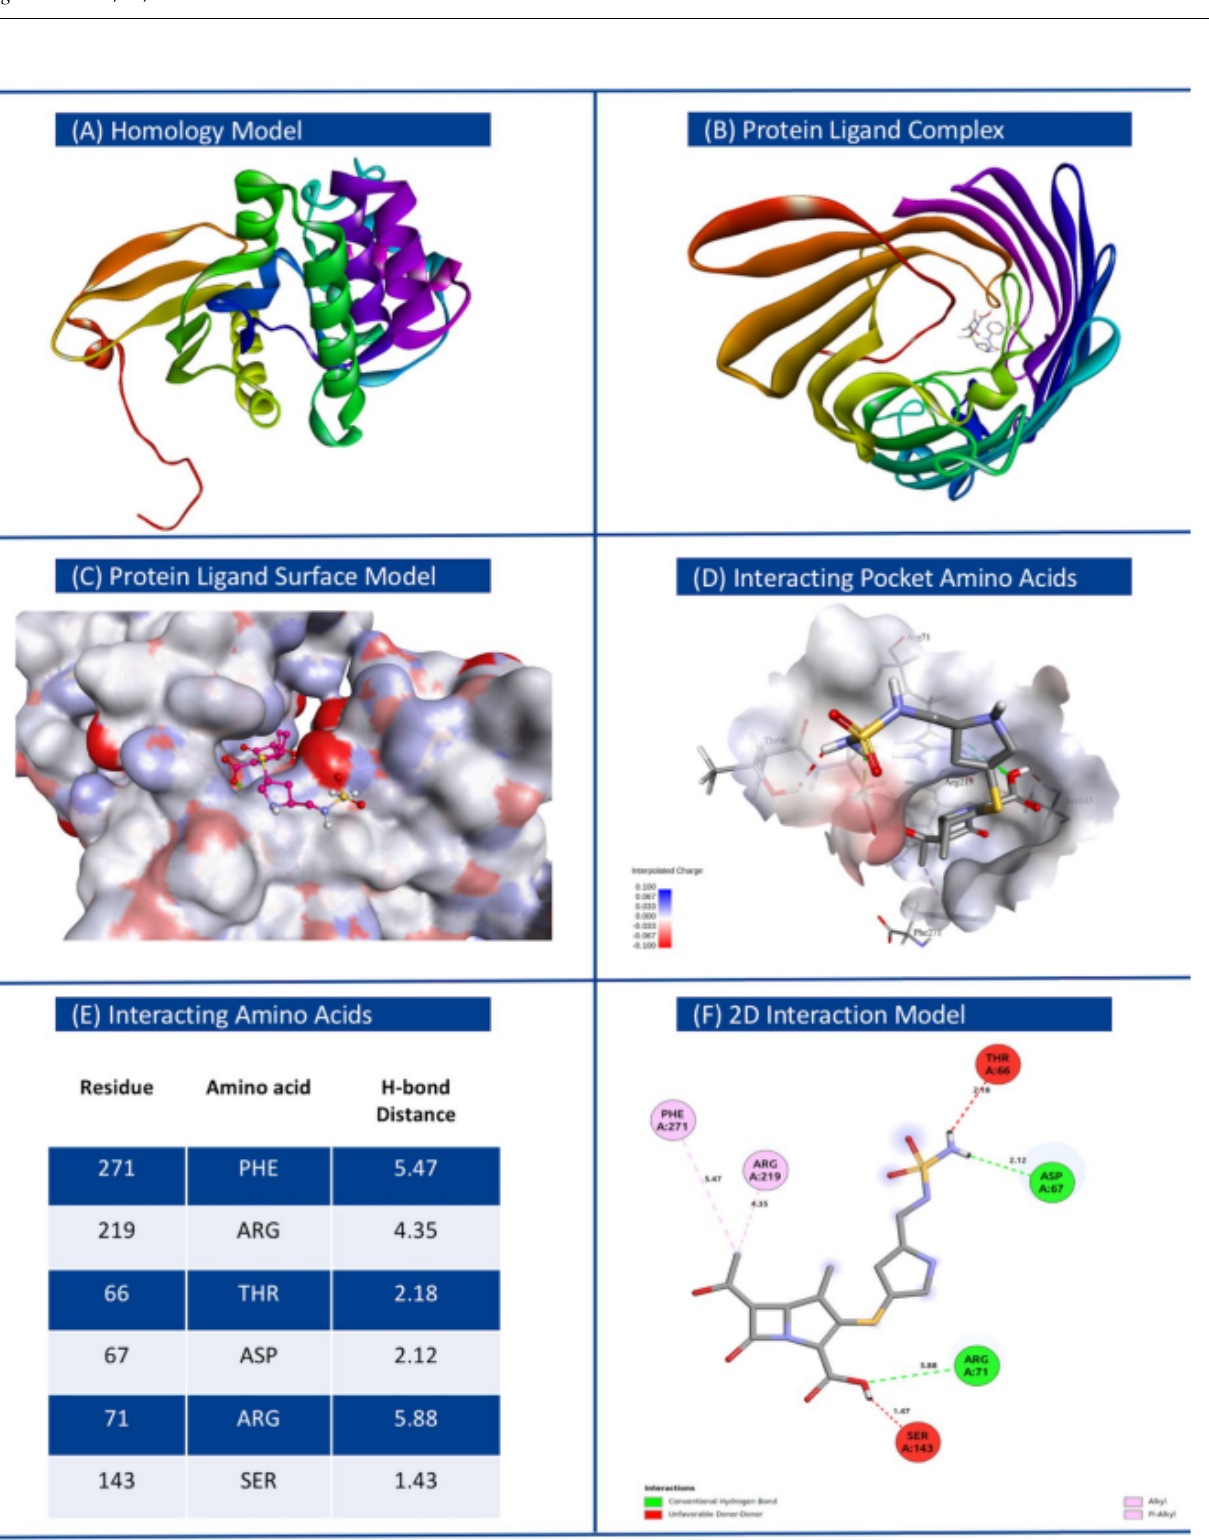
Figure 6. Homology model of protein O-phosphotransferase (WP_000018330.1) based on PDB template, and molecular docking with ligand (Doripenem) for Klebsiella pneumoniae . ( A ) Atomic resolution of target protein and its three-dimensional structure. ( B ) Protein ligand complex docked model (top view). ( C ) Binding surface plot of protein and ligand docking. ( D ) Interacting amino acids with interpolated charges inside the interacting pocket. ( E ) Details of residue, amino acids, and H-bond distance. ( F ) 2D interaction model with interaction bond types.